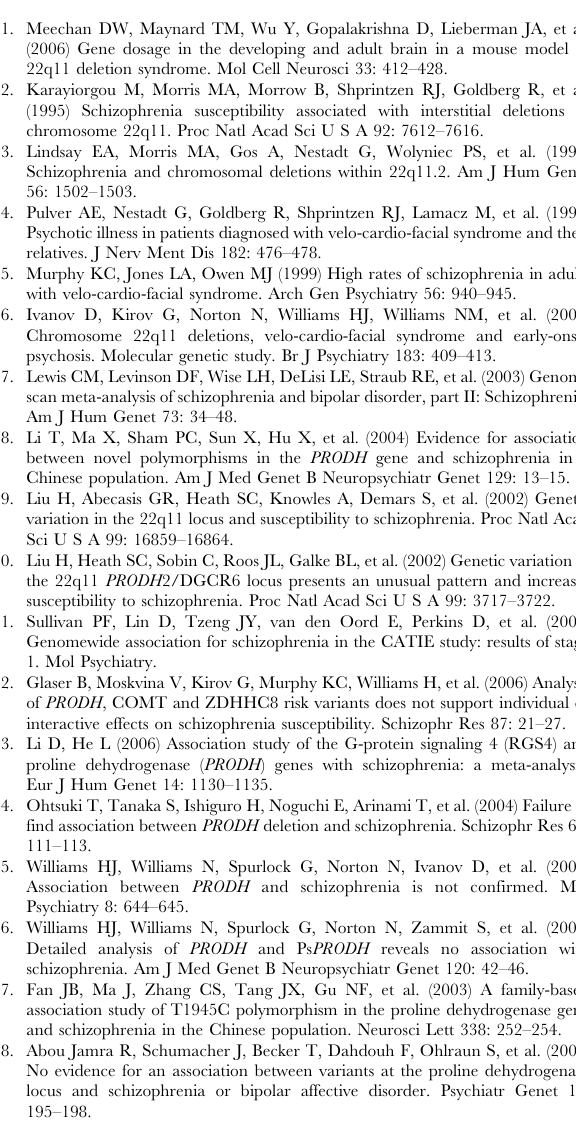
Table S1 Morphometry results.